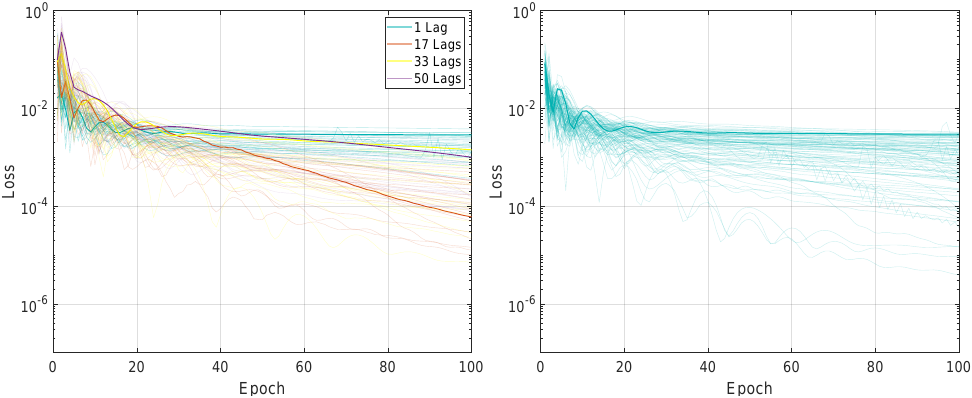
Figure 14. Illustration of the training loss for Experiment 1, LSTMTF ( left ) and VLSTM ( right ), using a many-to-many prediction mode. The highlighted thick lines represent the training loss for a mini-batch size of 2.